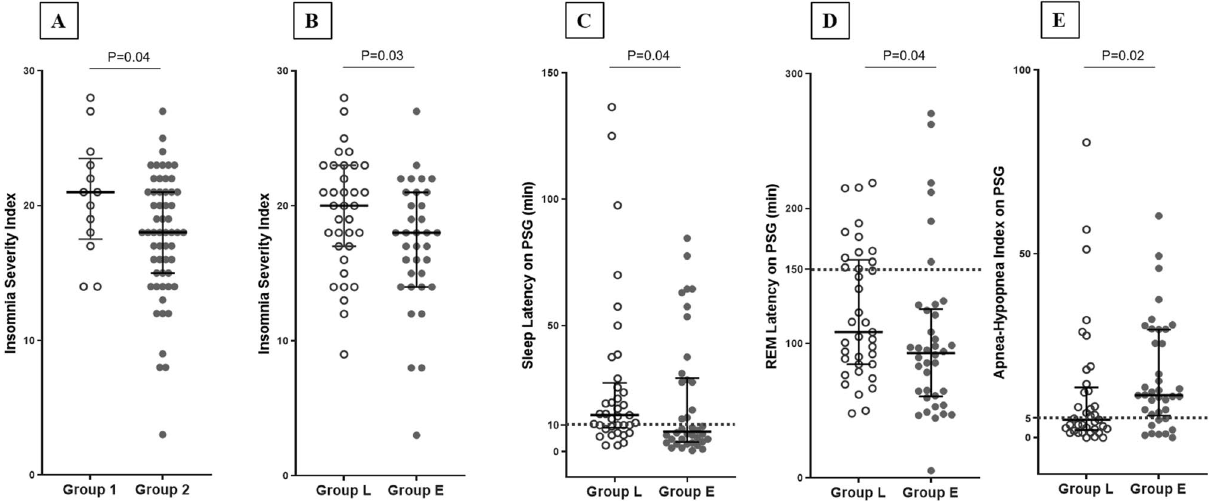
Figure 2. Differences in clinical symptom scores and PSG parameters between groups according to rest-activity patterns and circadian phase ( A–E ). Group 1 (low IS and high IV), Group 2 (high IS and low IV), Group L (late phase), and Group E (early phase). Student’s t-test was performed to analyze normally distributed continuous variables (ISI), and the Mann–Whitney U test was conducted to analyze non-normally distributed continuous variables (sleep latency and AHI). Five participants did not complete the insomnia severity index (n = 70). Circles indicate patients. Bars in the middle indicate medians, while error bars indicate interquartile range. Dotted lines in ( C ), ( D ), and ( E ) indicate the conventional cut-off points for each PSG parameter. AHI apnea– hypopnea index, IS inter-daily stability, IV intra-daily variability, L5 onset time least active 5-h onset time, M10 onset time most active 10-h onset